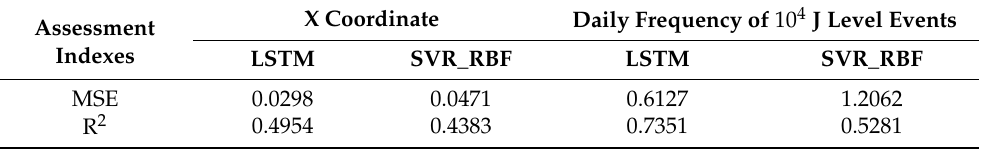
Table 8. Model performance for out-of-sample